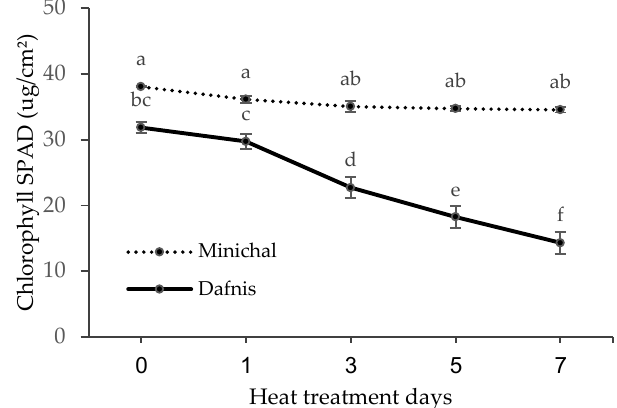
Figure 2. Differences in heat tolerance after 7 days of stress regime among seedlings of tomatoes Minichal ( a ) and Dafnis ( b ).